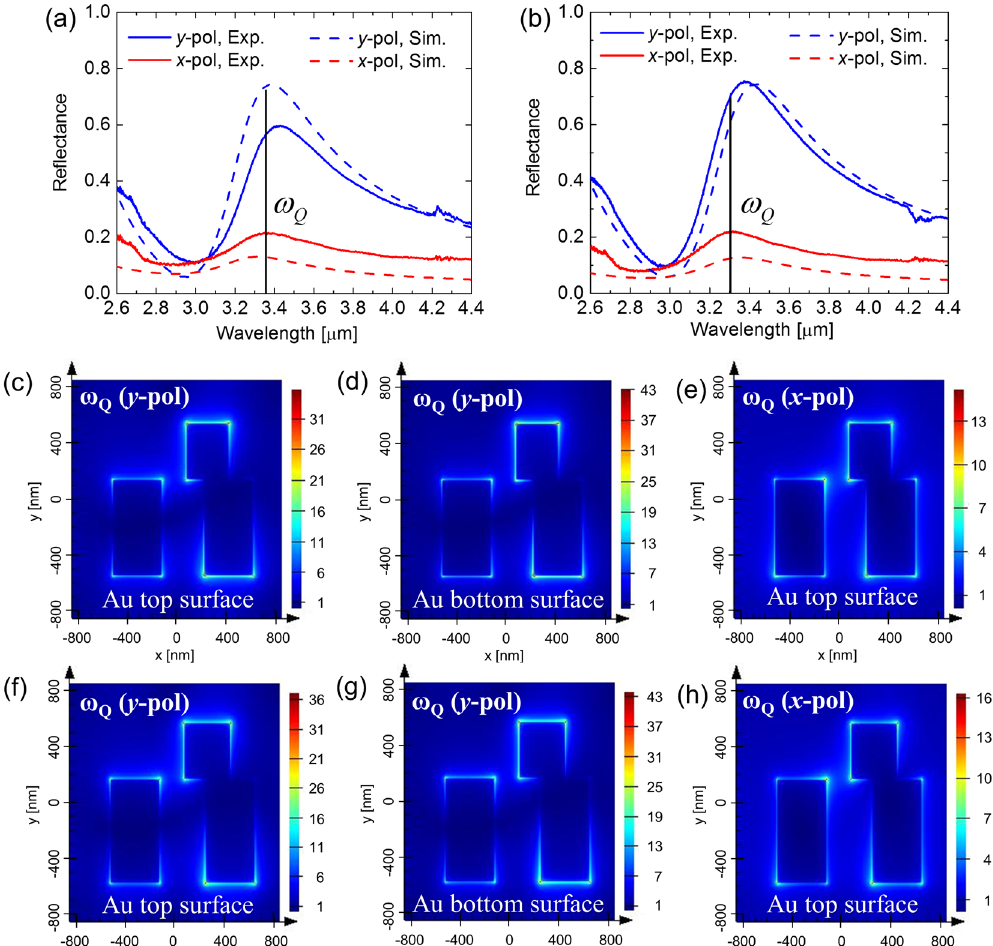
Figure 2. Measured (solid line) and simulated (dashed line) reflection spectrum of the bare control FMM ( a ) and the bare FMM on the nanopedestal structure ( b ) for x-polarized (red) and y-polarized (blue) incident light. The black solid line indicates the quadrupole resonance frequency of each structure. Top views of the simulated E-field enhancement distribution for the control FMM monitored ( c ) at the top and ( d ) the bottom Au surface at the quadrupole resonance frequency ( λ = 3.24 μ m) excited from y-polarized incident light, and ( e ) at the top Au surface at the quadrupole resonance excited from x-polarized incident light. Top views of the simulated near-field enhancement distribution for the FMM on the nanopedestal structure monitored ( f ) at the top and ( g ) at the bottom Au surface at the quadrupole resonance frequency ( λ = 3.29 μ m) excited from y-polarized incident light, and ( h ) at the top Au surface at the quadrupole resonance excited from x-polarized incident